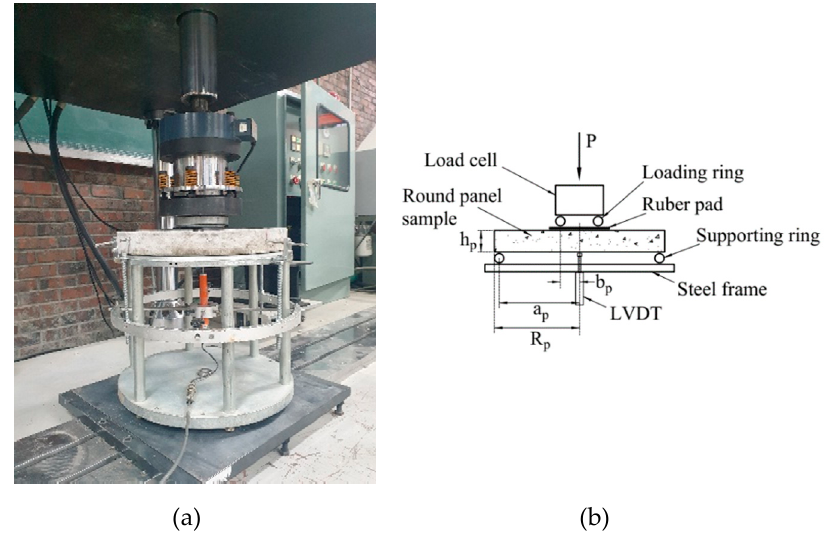
Figure 4. Photograph ( a ) and schematic ( b ) of the biaxial flexural test.